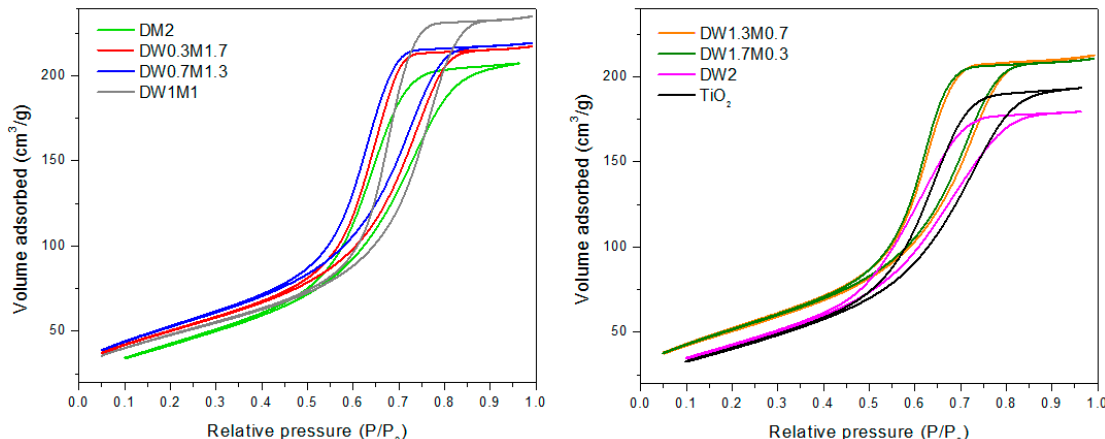
Figure 5. N 2 adsorption-desorption isotherms of undoped, doped, and co-doped TiO 2 with different weight percentages of W and Mo ions.